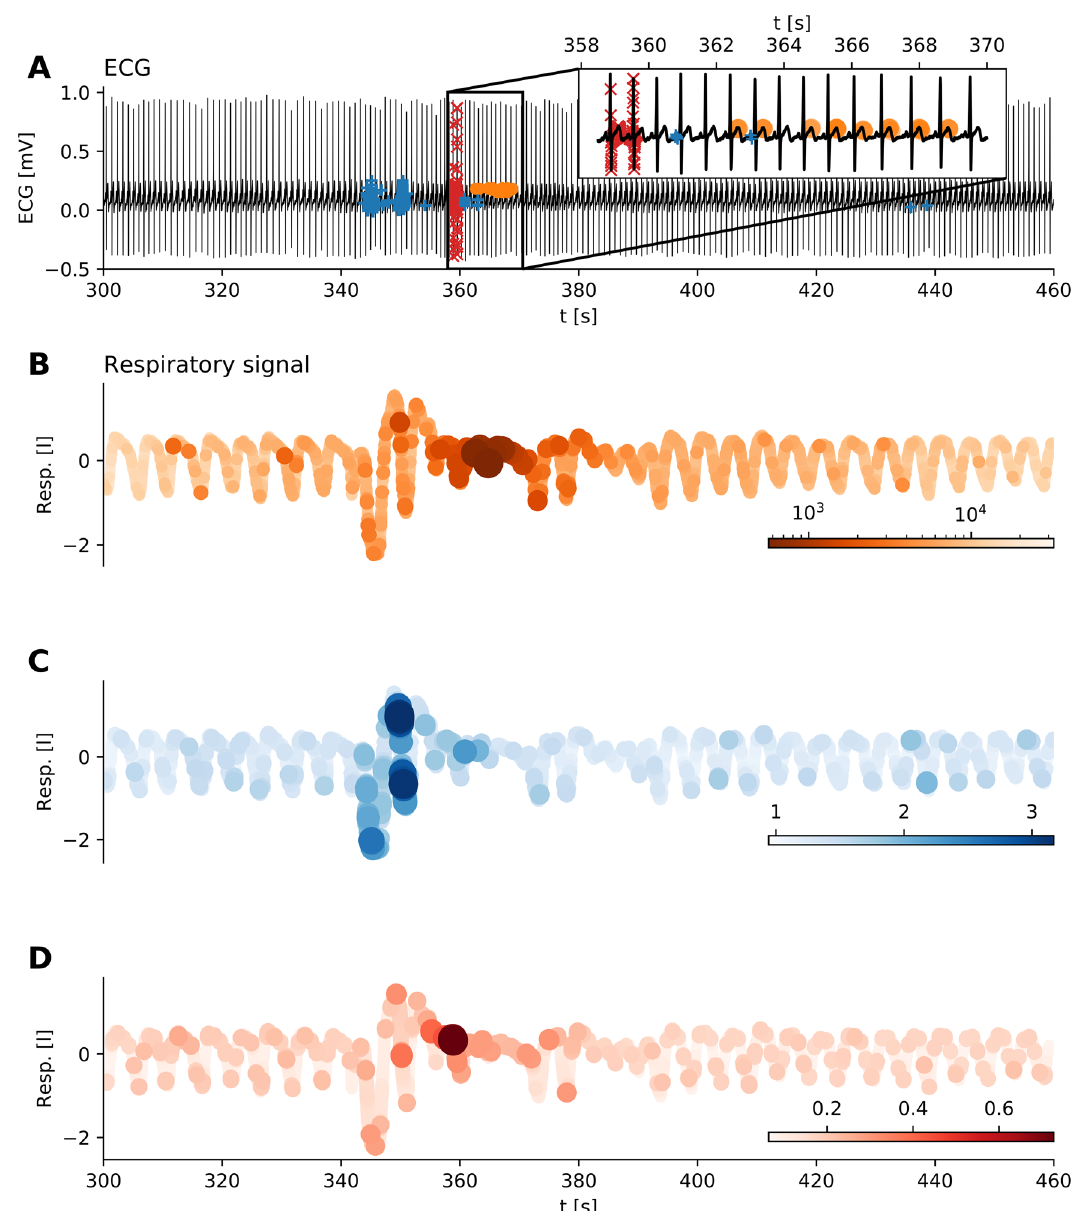
Figure 5. Detecting apnea with arousal on ECG. ( A ) ECG time series with unique events detected by TOF (orange dots, E = 3, τ = 0.02s, k = 11, M = 5 s ), outliers detected by LOF (blue + signs, E = 7, τ = 0.02s, k = 100 , threshold = 0.5% ) and the top discord (red x signs, M=5 s). The inset shows the more detailed pattern of detections: unique behavior mainly appears on the T waves. ( B – D ) Breathing air-flow time series parallel to the above ECG recording, colored according to the scores of the three anomaly methods. The anomaly starts with a period of irregular breathing at 340 s, followed by the apnea when breathing almost stops (350–370 s). After this anomalous period, arousal restores the normal breathing. ( B ) Airflow is colored according to the TOF score at each sample. Low values (darker colors) mark the anomaly corresponding to the period of apnea. ( C ) Air-flow time series with coloring corresponds to the LOF score at each sample. Higher LOF values mark the outliers. LOF finds irregular breathing preceding the apnea. ( D ) Airflow time series colored according to the matrix profile values by the discord. Discord detection algorithm finds the point of transition from irregular breathing to the